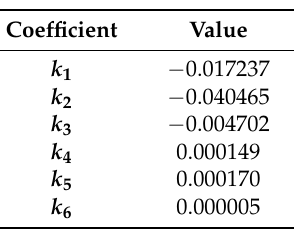
Table 1. Value of coefficients k 1 to k 6 . Source: [37].